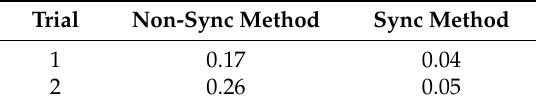
Table 3. Uncoded bit error rate at 4